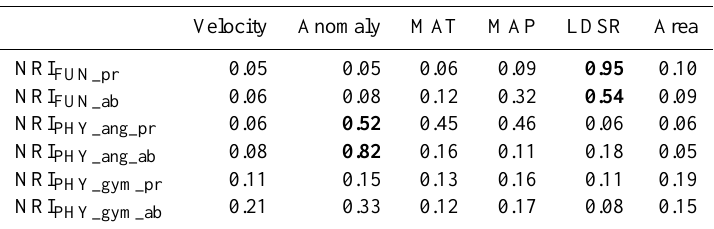
Table 3. Summed Akaike weights ( w ) for each predictor variable based on all possible single- and two-predictor OLSs. Variables with w ≥ 0 . 50 are given in bold.